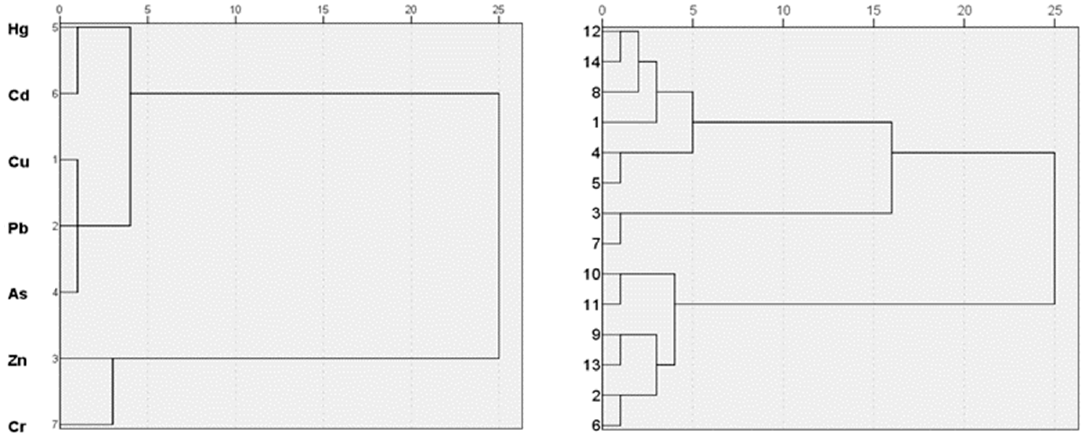
Figure 7. Cluster analysis results in 2018.